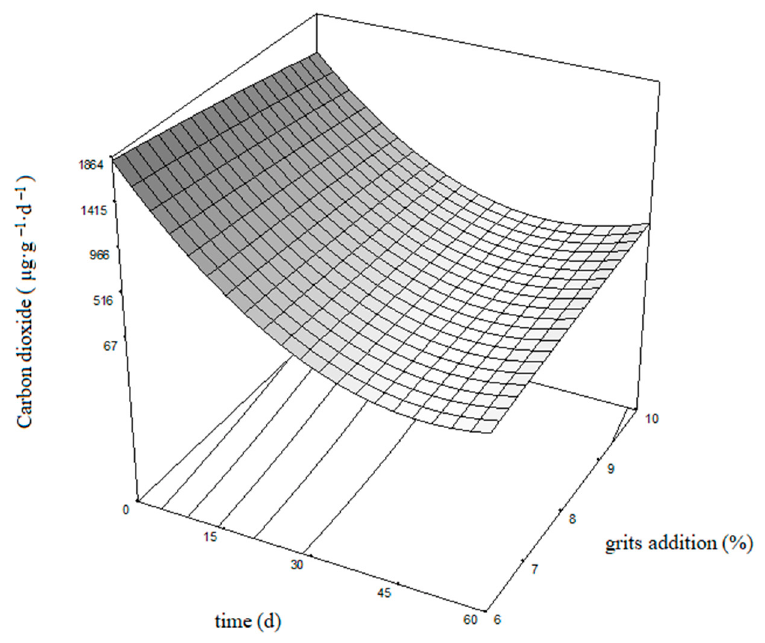
Figure 5. Released CO 2 evolution as a function of the composting process time and grits addition. Initial basal respiration was about 2000 µg·g − 1 ·d − 1 and decreased at the end of the process to stable values in the 300–430 range for all the grit addition ranges. Similar val- ues in the 300–600 µg·g − 1 ·d − 1 range were informed by Gattinger et al. [49] and Zambrano et al. [32], as long as Brewer and Sullivan [50] described values of 700 µg·g − 1 ·d − 1 at the end of a 70-day forced aeration composting